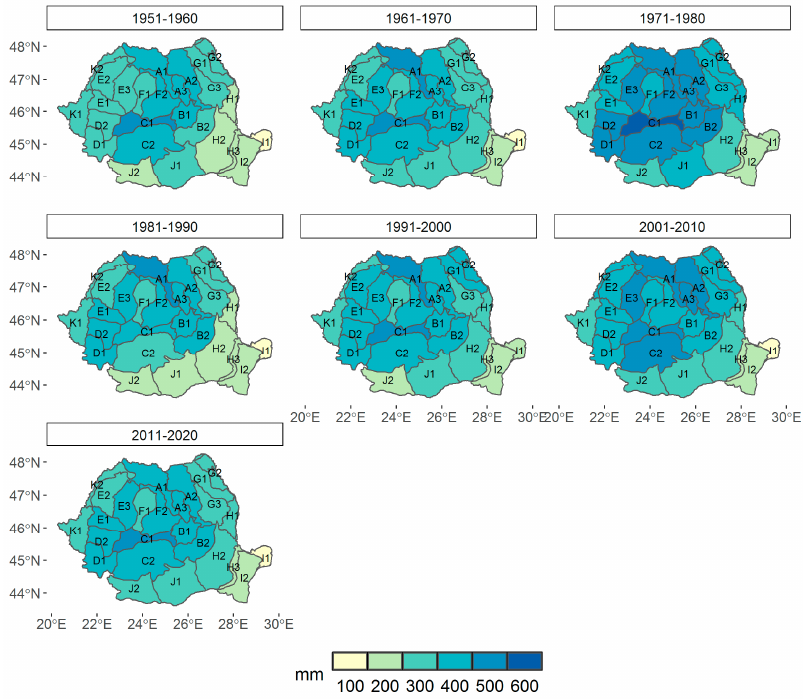
Figure 7. The variation of AP VS on the decades for the provenance subregions.